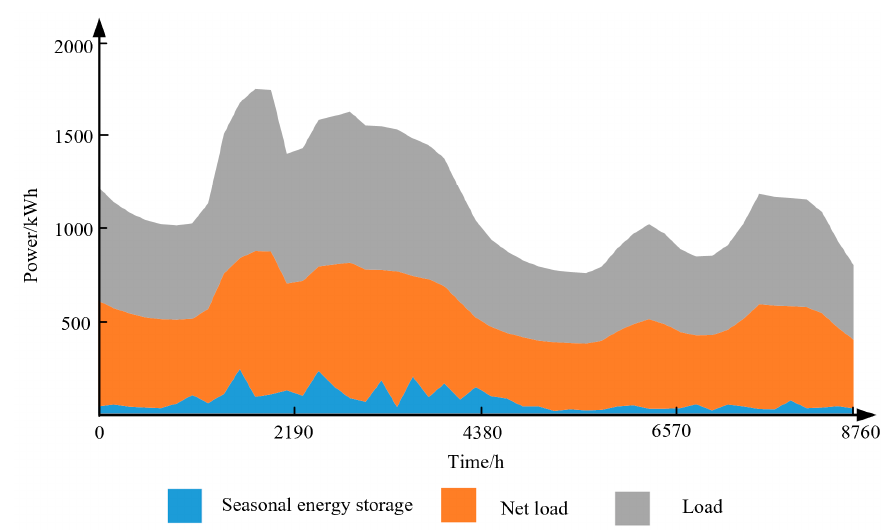
Figure A1. Schematic Diagram of the Function of Seasonal Energy Storage. Table A1. Classification of Energy Storage System.